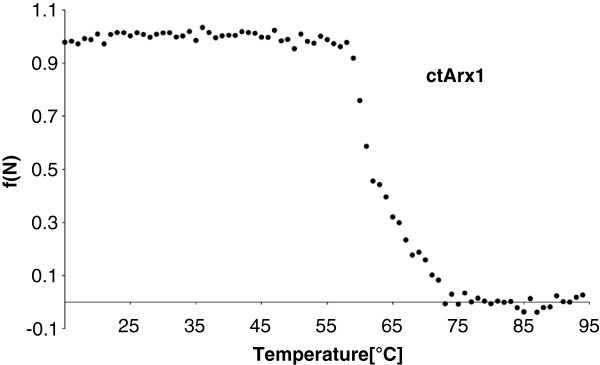
CD spectrum of ctArx1. The protein core of ctArx1 unfolds around 62°C. Unfolding of ctArx1 at ~0.1 mg/ml concentration is monitored by CD at 222.6 nm under a temperature gradient. The normalized ellipticity is plotted against the temperature.